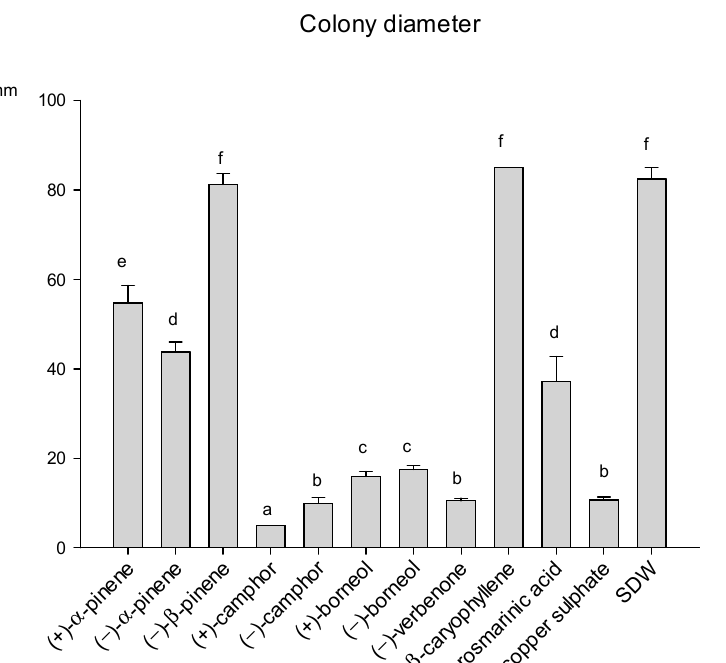
Figure 5. Growth of A. alternata colony diameter (mm) in the presence of different compounds of rosemary leaves, after 14 days of incubation at 25 ◦ C. Data are means of 6 replicates + SE (standard error). Different letters indicate significant differences (by the Mann–Whitney U-test, p < 0.05) among the tested compounds.